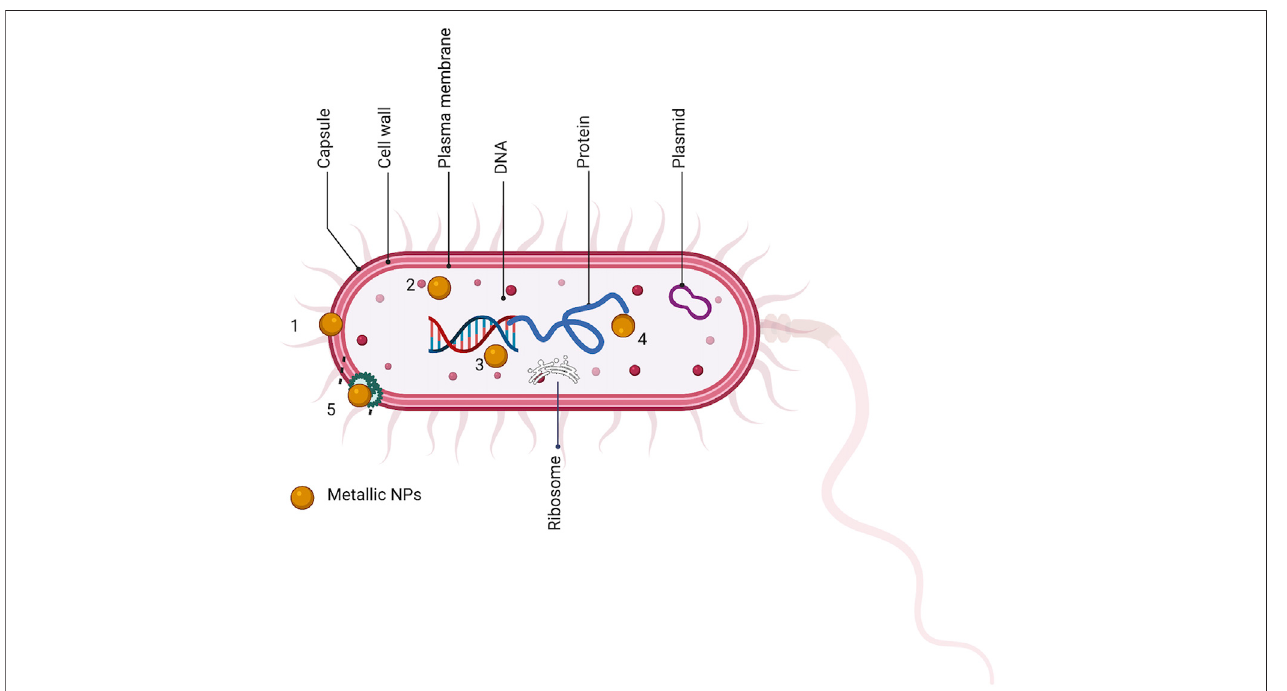
FIGURE 3 | Sites of action of metal nanoparticle synthesized with natural product (MNps) on bacteria. Both components give synergically activity via similar mechanism of action bacterial cells. 1. bacterial ef fl ux pump. 2. bacterial DNA. 3. bacterial ribosome. 4. bacterial protein. 5. bacterial cell walls integrity.